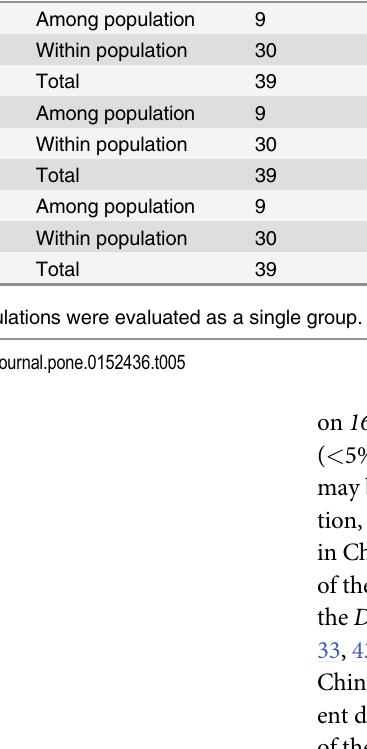
Table 5. Analysis of molecular variance (AMOVA) based on the 16S rDNA, CO I gene and 18S gene sequences of D . pulex in the middle and lower reaches of Yangtze River. Source of variation